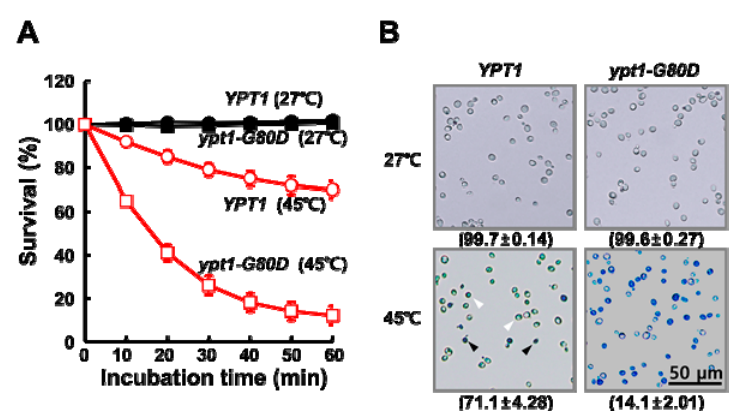
Figure 1. Mutant ypt1-G80D Yeast Cells are Sensitive to Heat-Stress . (A) Effect of heat treatment on cell viability. YPT1 and ypt1-G80D cells (5 × 10 7 cells/mL) grown in YPD medium were incubated at 27 °C or 45 °C, and samples were withdrawn at the indicated times for measurement of viable counts. Cell survival (percent) at each time point was calculated as 100× the ratio of the viable count at that time to the viable count at time zero. Error bars: means ± SD of at least 3 independent experiments. (B) Trypan blue (TB) exclusion assay of heat-shock-induced cell death. Samples of the YPT1 and ypt1-G80D cells at the 60 min time point in (A) were visualized by fluorescence microscopy after staining with TB. The percentages of TB-negative cells are shown below the images. Data are represented as the mean ± SD of at least three independent experiments. White and black arrowheads show examples of TB-negative and -positive cells, respectively. Scale bar, 50 μ m.